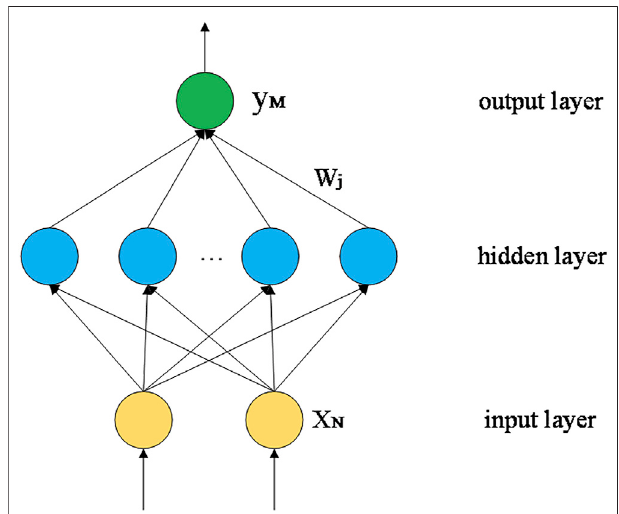
FIGURE 1 | The structure of the RBF neural